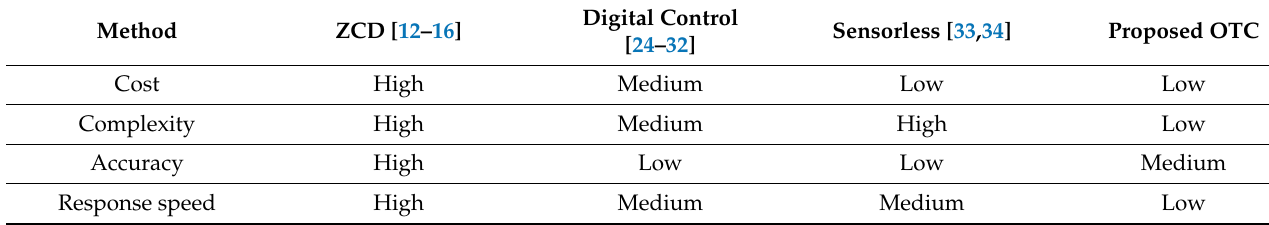
Table 3. The comparison of BCM controls.